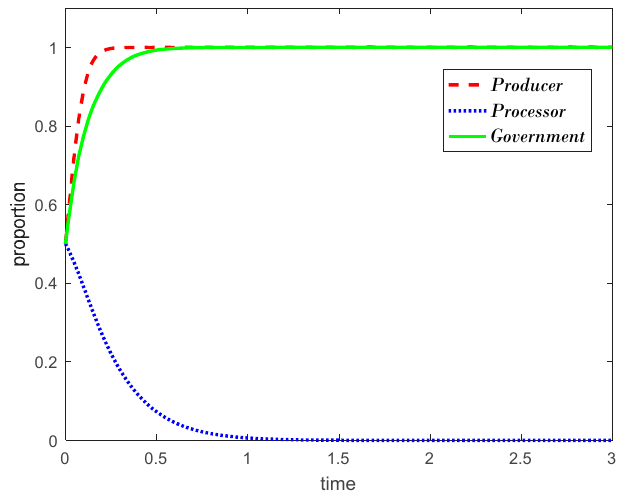
Figure 4. The evolutionary path of case 2. The values in case 3 (in Table 4) meet the local stability scenario 3, and the evolution trajectory is illustrated in Figure 5.